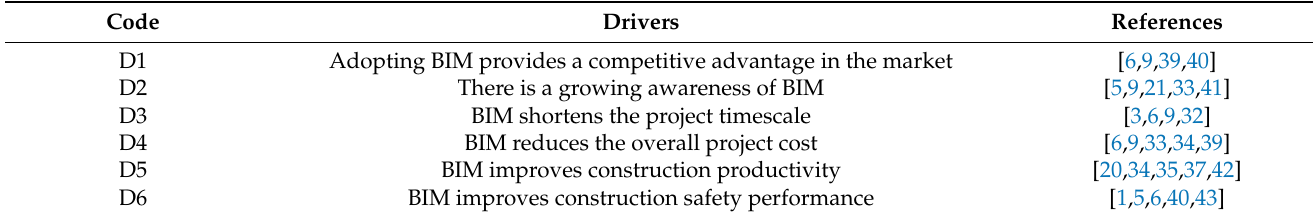
Table 1. Drivers/benefits of Building Information Modeling